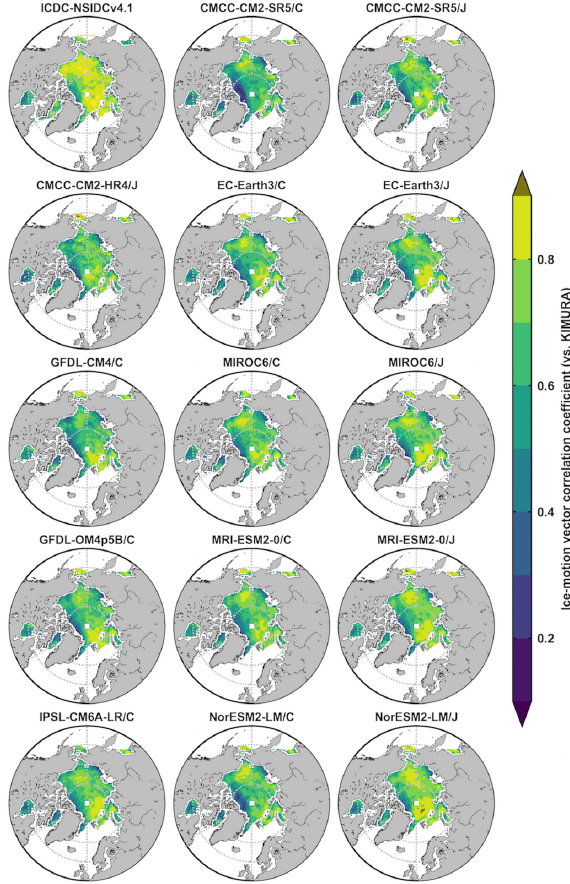
Figure 8. The significant Arctic ice-motion vector correlation co- efficients from monthly mean data during 2003–2007 at a level of 99% between ICDC-NSIDCv4.1/model outputs and the KIMURA data. The second and third columns are from the five OMIP1 and OMIP2 model outputs of CMCC-CM2-SR5, EC-Earth3, MIROC6, MRI-ESM2-0, and NorESM2-LM,